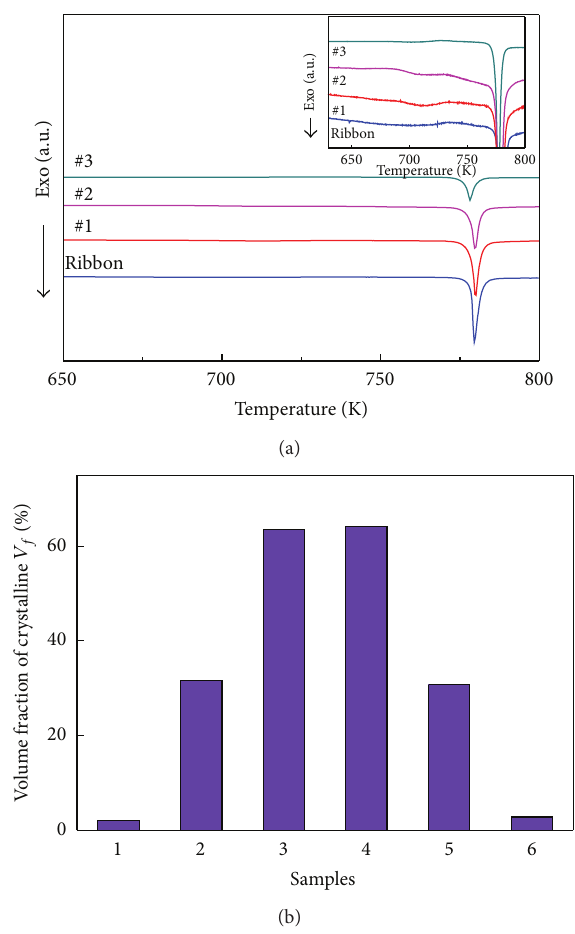
Figure 2: (a) DSC curves of Zr51 alloy for locations #1, #2, and # 3 as wellasribbonsample,(insetina)anenlargedsectionbelowtheglass transition temperature, and (b) the volume fraction of crystalline for different